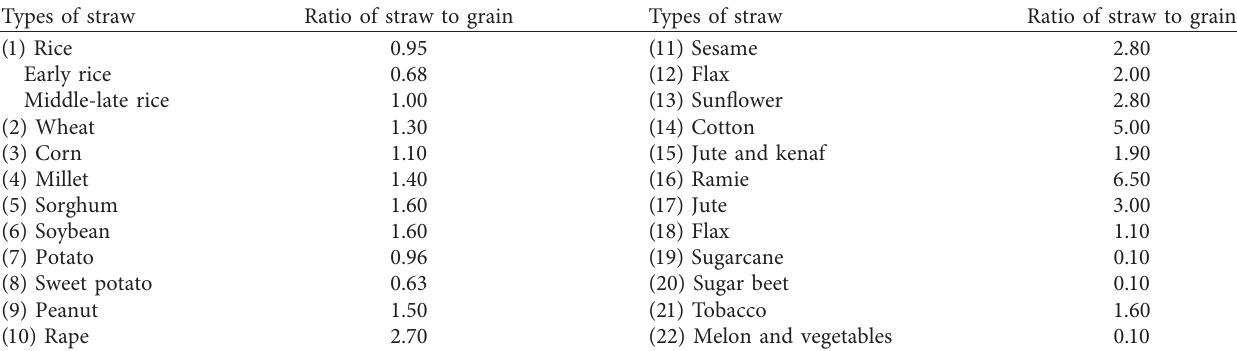
Table 1: Ratio of straw to grain.